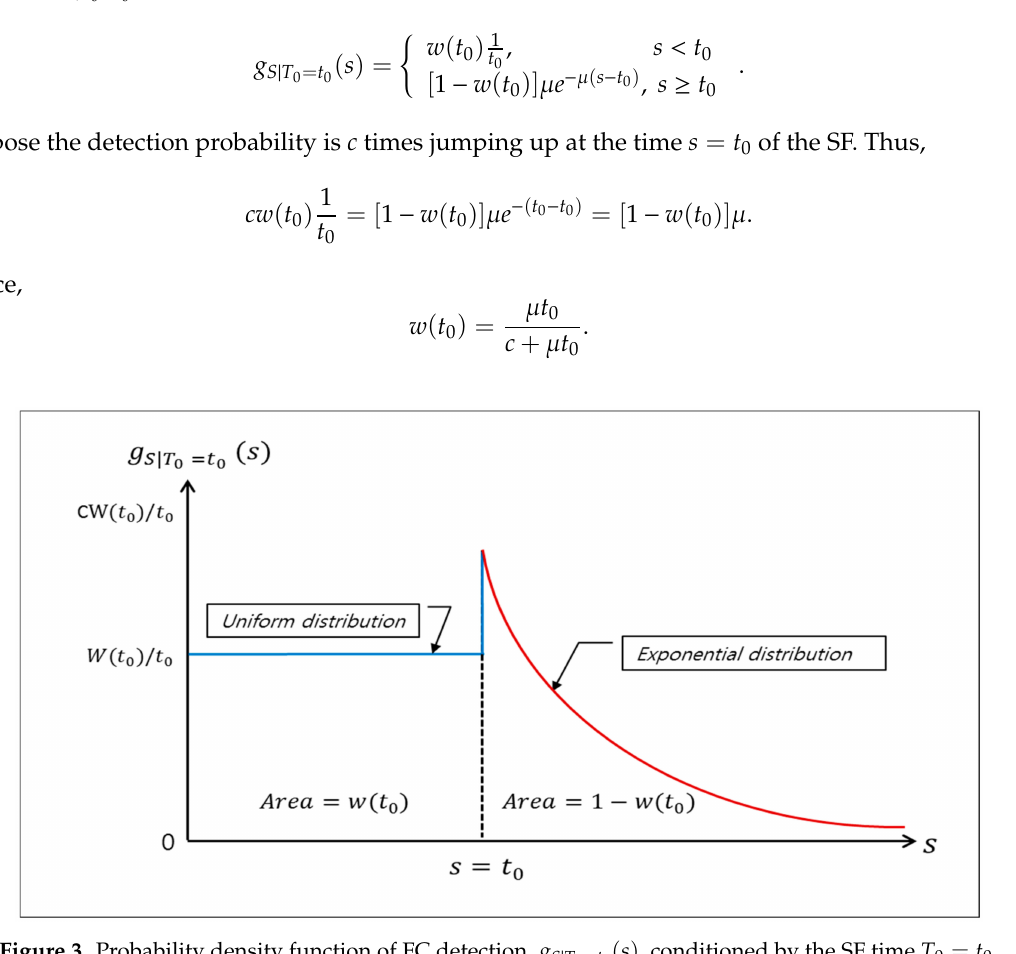
Figure 3. Probability density function of FC detection, g S | T